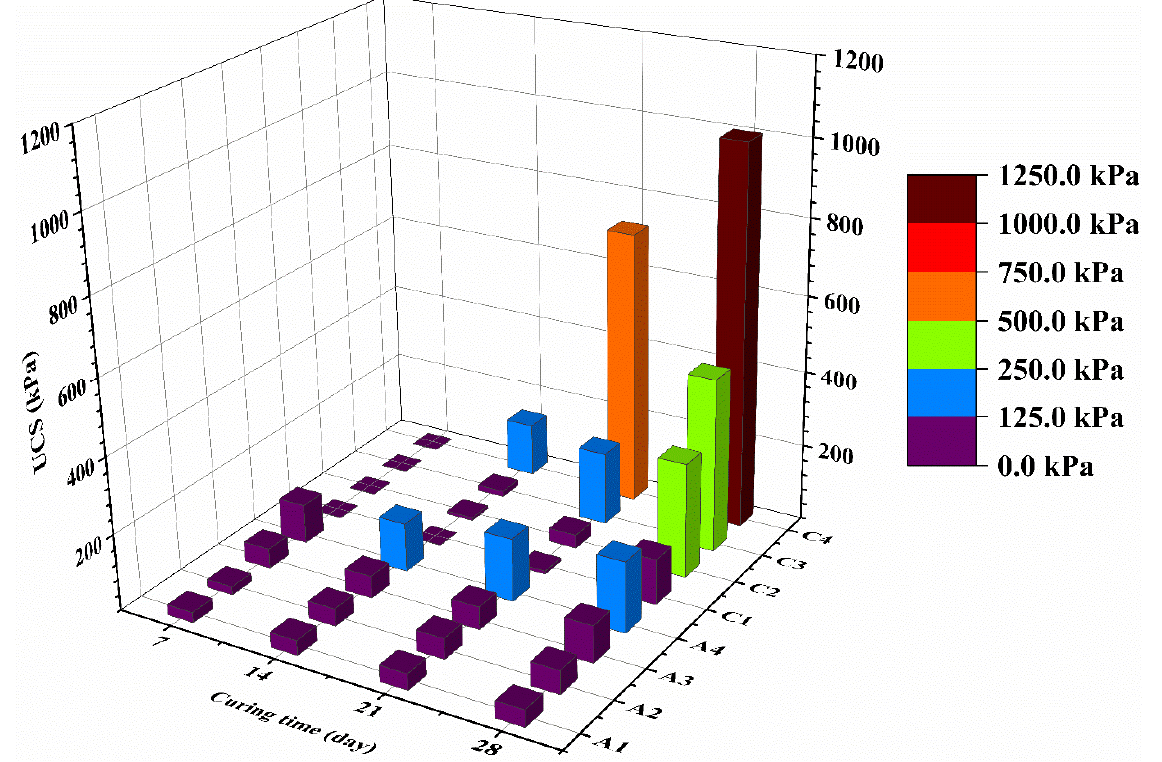
Figure 2. UCS of solidified samples with the same water content.